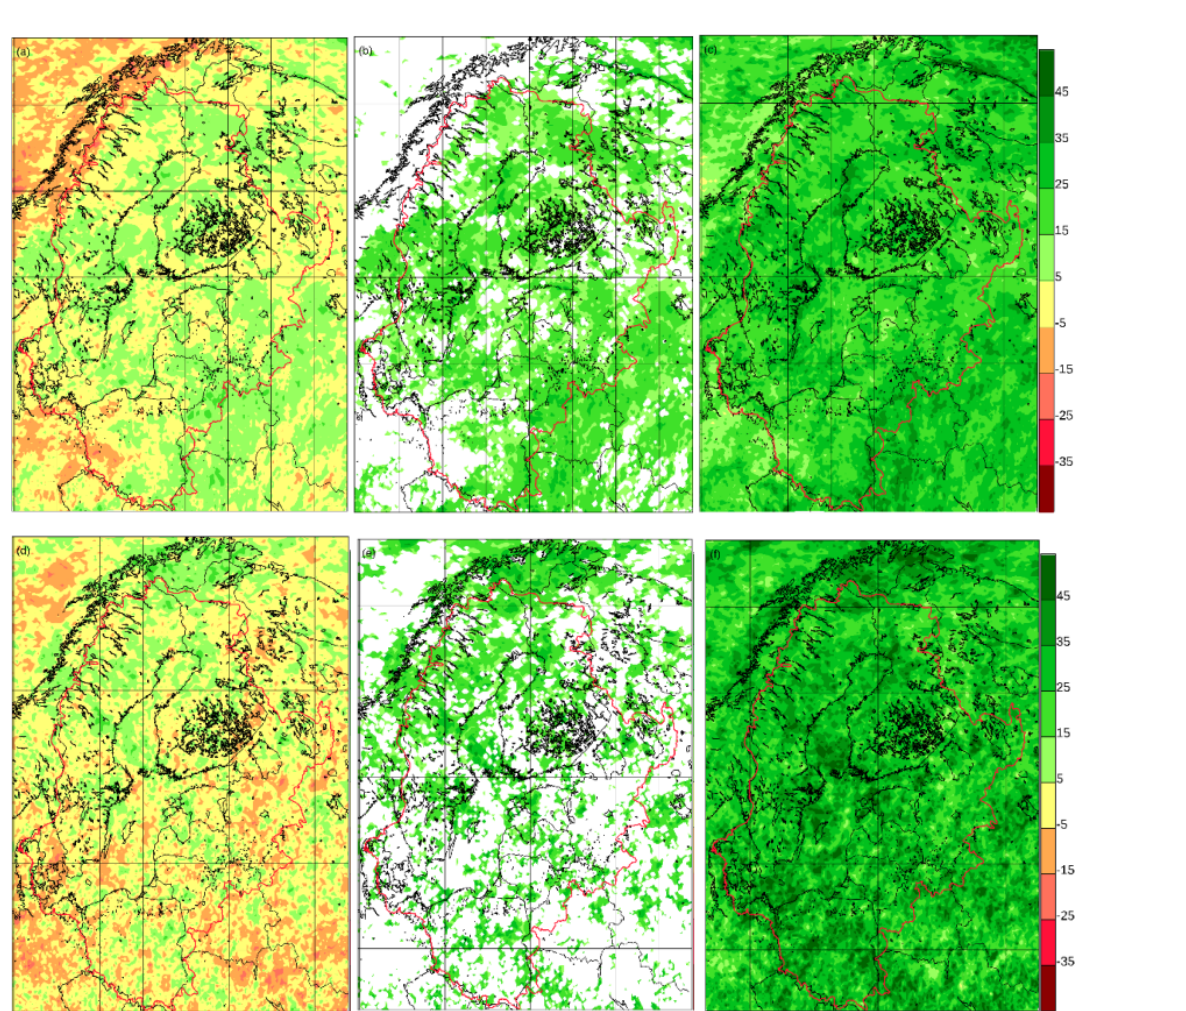
Figure 6. Change in the 10-year return value of daily precipitation change (%) between 1971 and 2000 and between 2071 and 2100 for 15 simulations from EURO-CORDEX according to the RCP8.5 scenario. The top row (a, b, c) shows winter, whereas the bottom row (d, e, f) shows summer. The left column is the lowest quartile (a, d) , the middle column is the median value (b, e) , and the right column is the higher quartile (c, f) . For the medians, only points where 75% of models agree on the sign are shown. This figure is based on data that are also discussed in Christensen and Kjellström (2018) and Christensen et al.